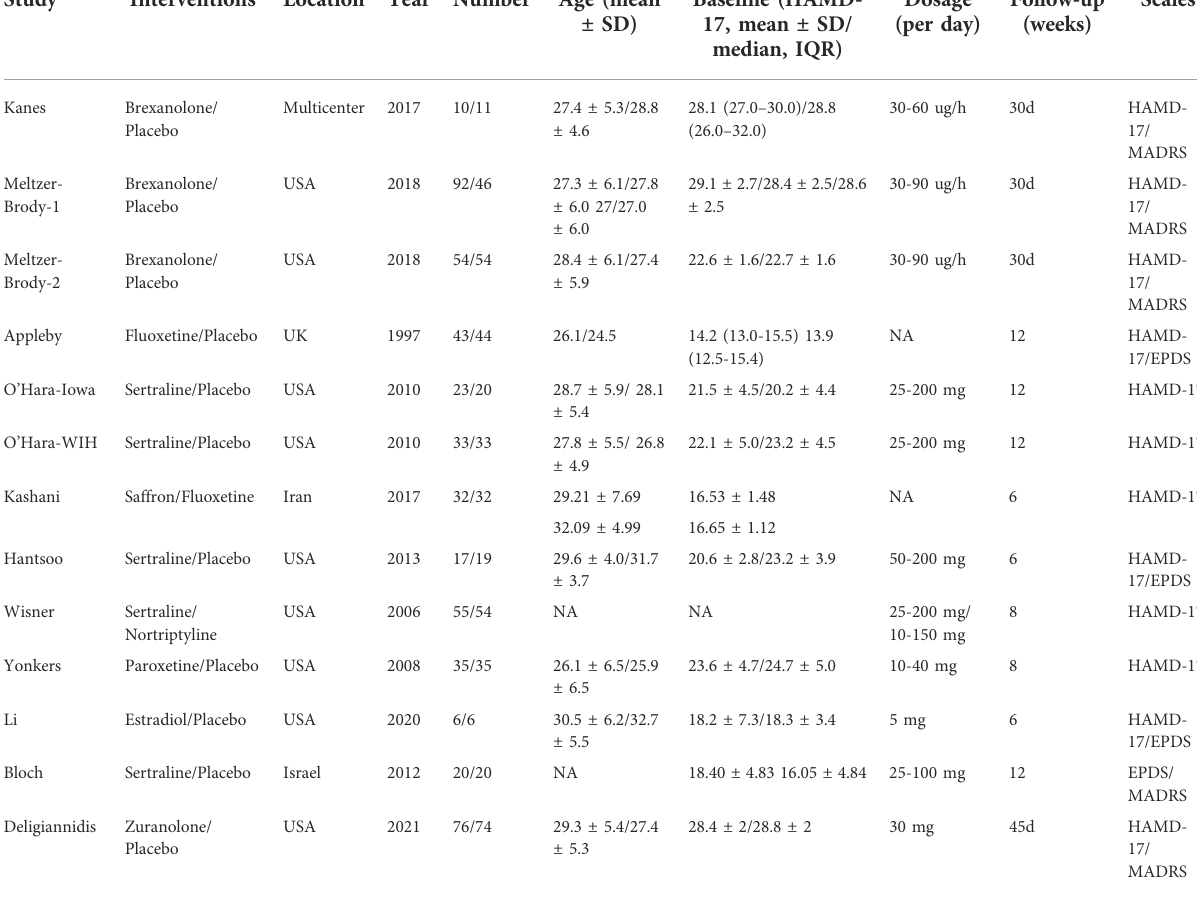
TABLE 1 Characteristics of included